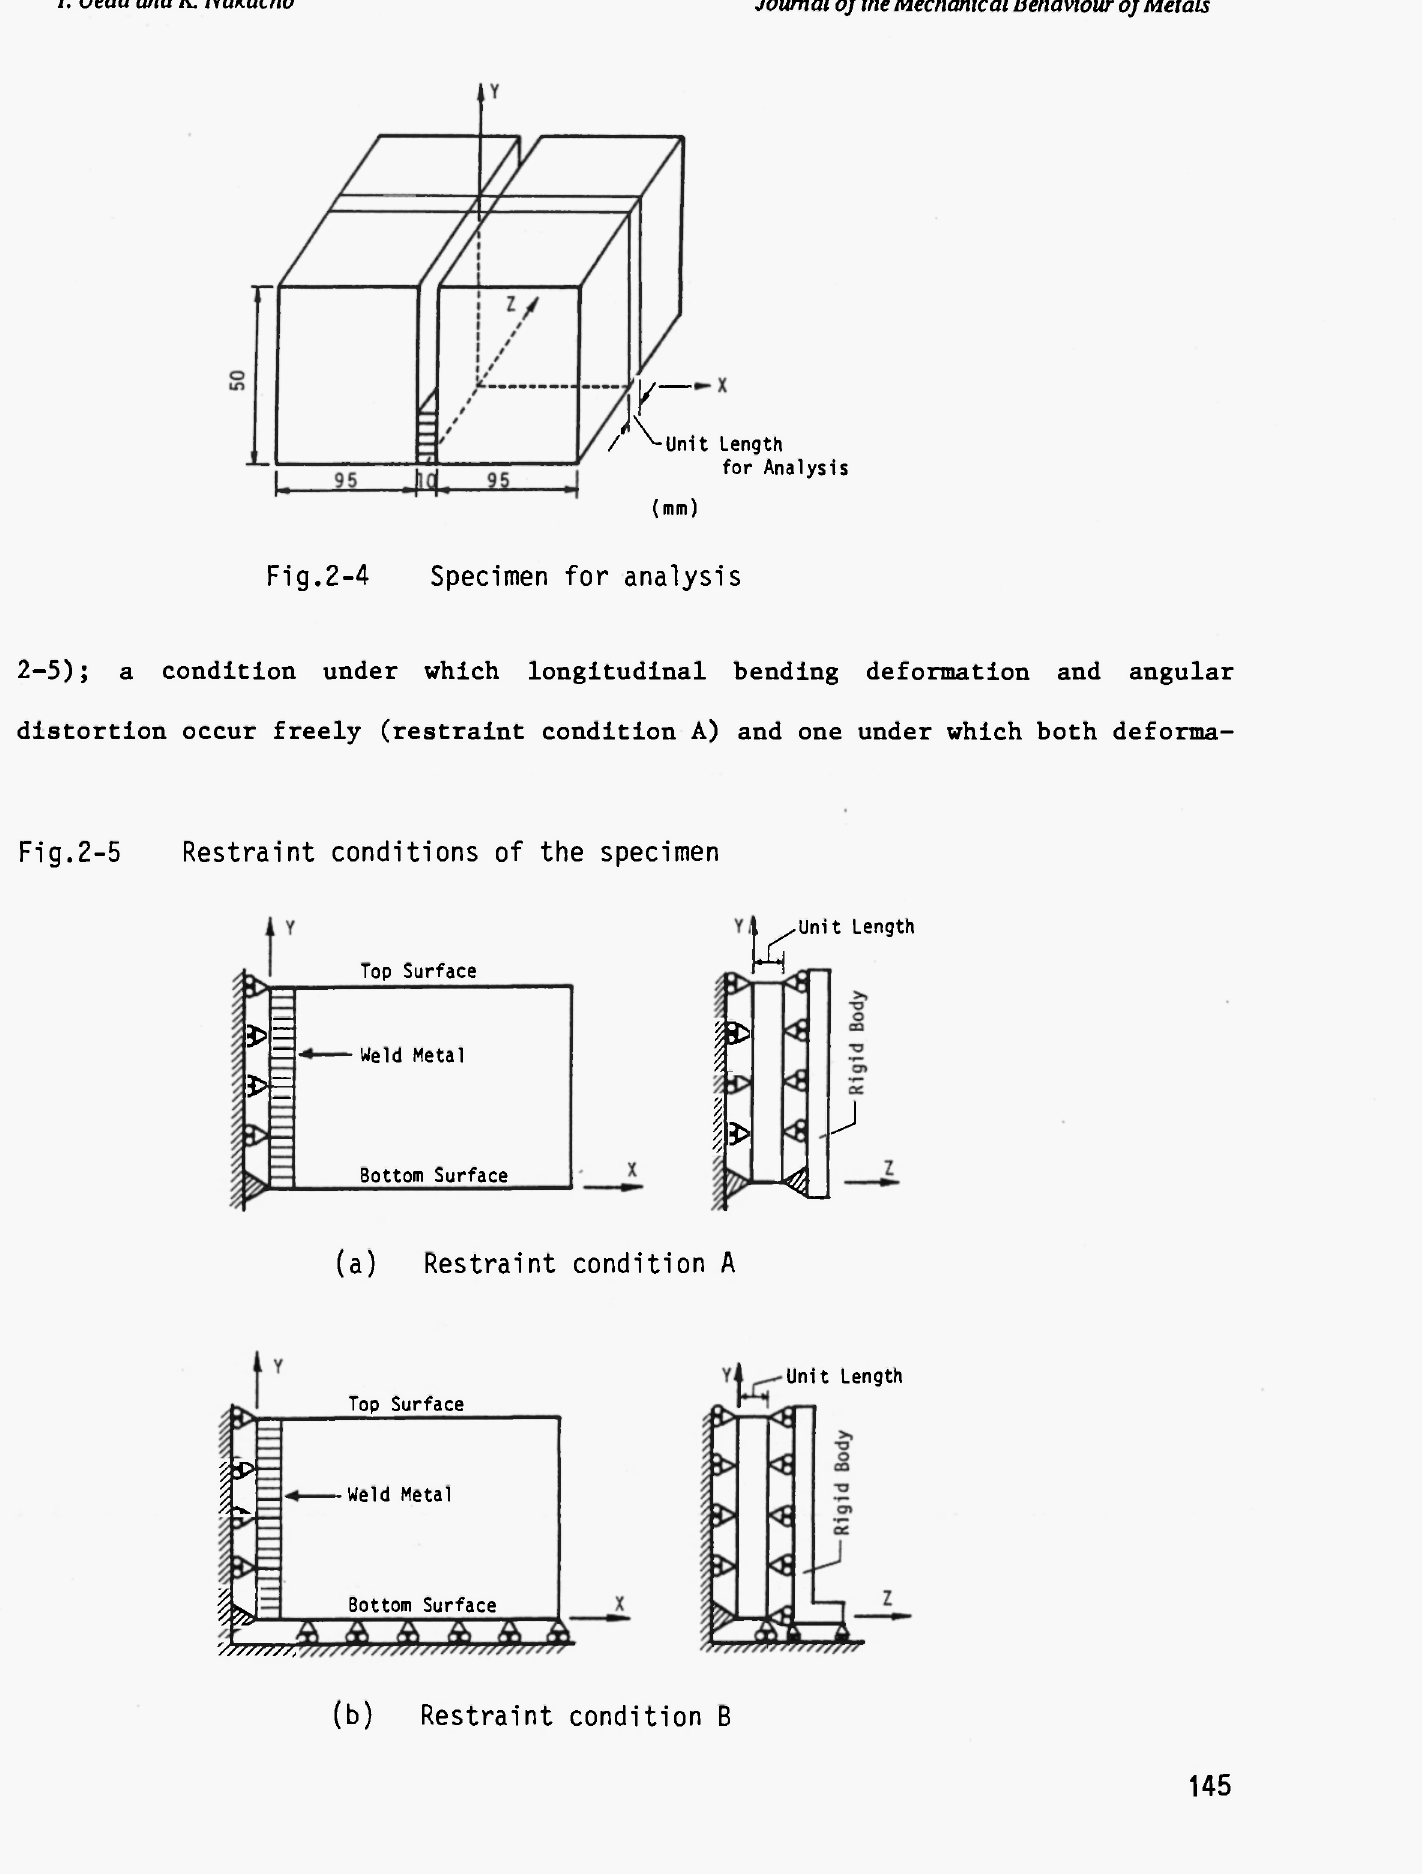
y— / ^ U n it Length for Analysis (mm)